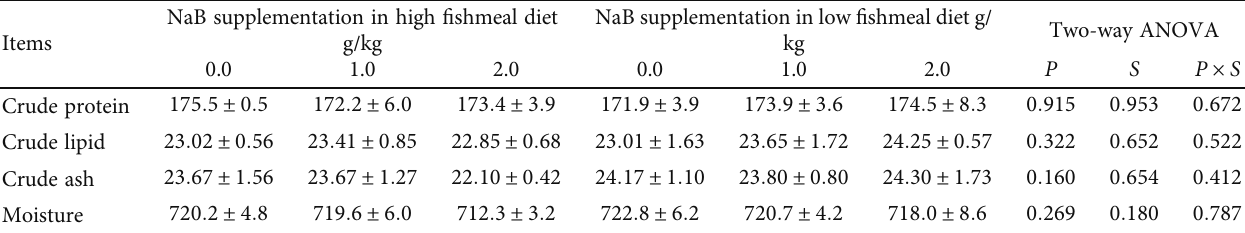
Table 3: E ff ect of dietary sodium butyrate on whole body proximate composition of rainbow trout (g/kg, fresh weight). NaB supplementation in high fi shmeal diet NaB supplementation in low fi shmeal diet g/ Items g/kg